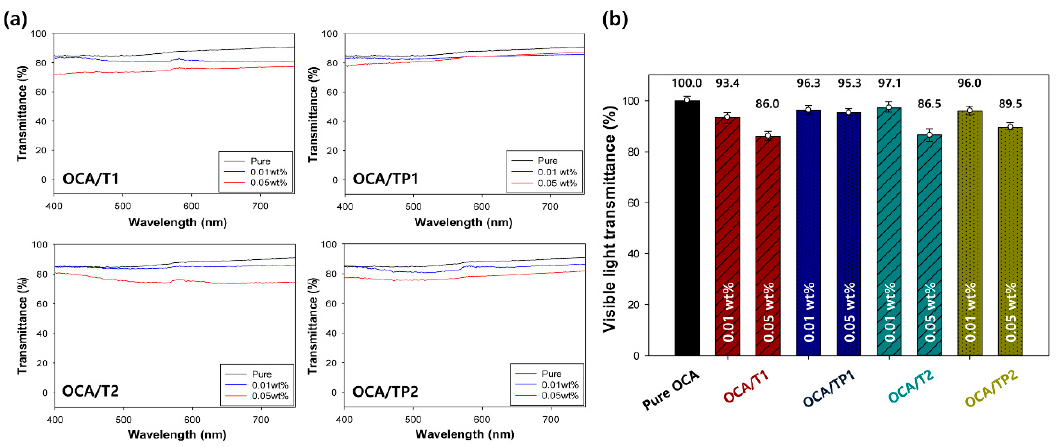
Figure 9. ( a ) UV–visible spectra and ( b ) average relative transmittances of the pure OCA and the nanoparticle-embedded OCA films in the visible light region.